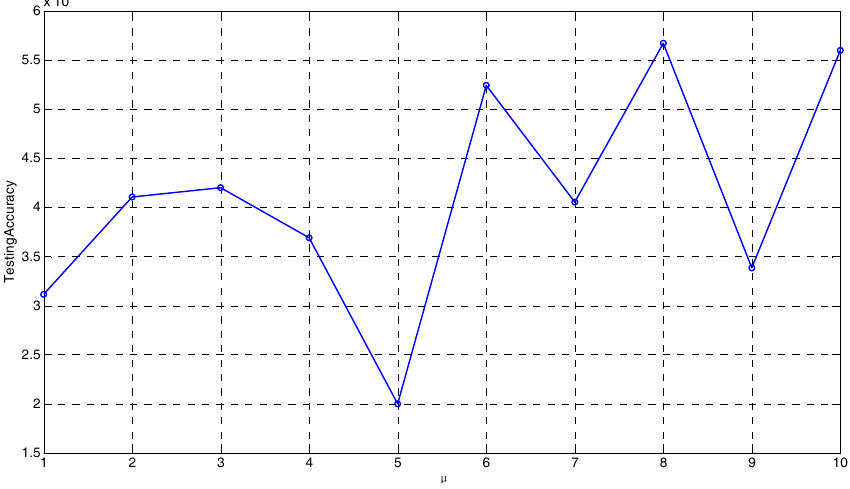
Sensors 2017 , 17 , 1847